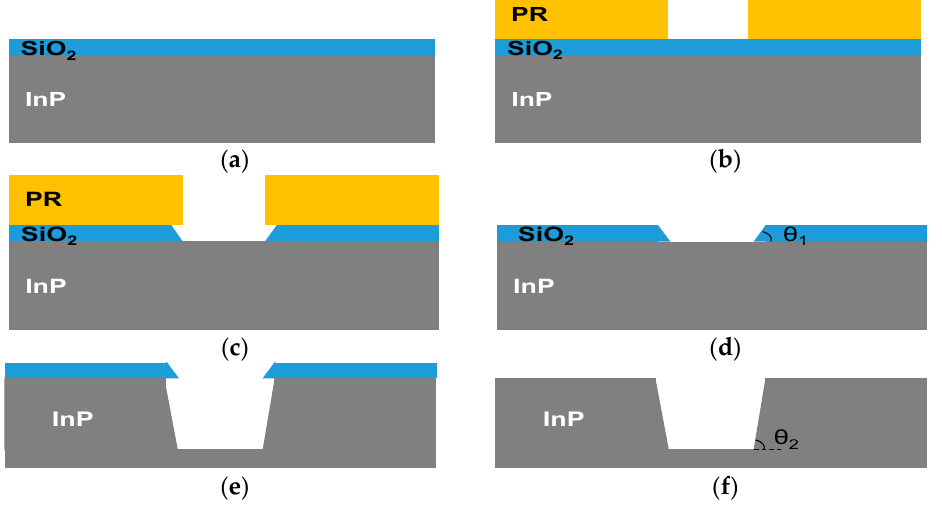
Figure 2. Cross-sectional view of a process flow for InP via holes: ( a ) SiO 2 deposition on InP substrate; ( b ) formation of photoresist (PR) mask; ( c ) SiO 2 patterning through the PR mask; ( d ) PR removal; ( e ) dry etching of the InP substrate; ( f ) SiO 2 removal. θ 1 and θ 2 are defined as sidewall slopes of the SiO 2 layer and InP substrate, respectively.